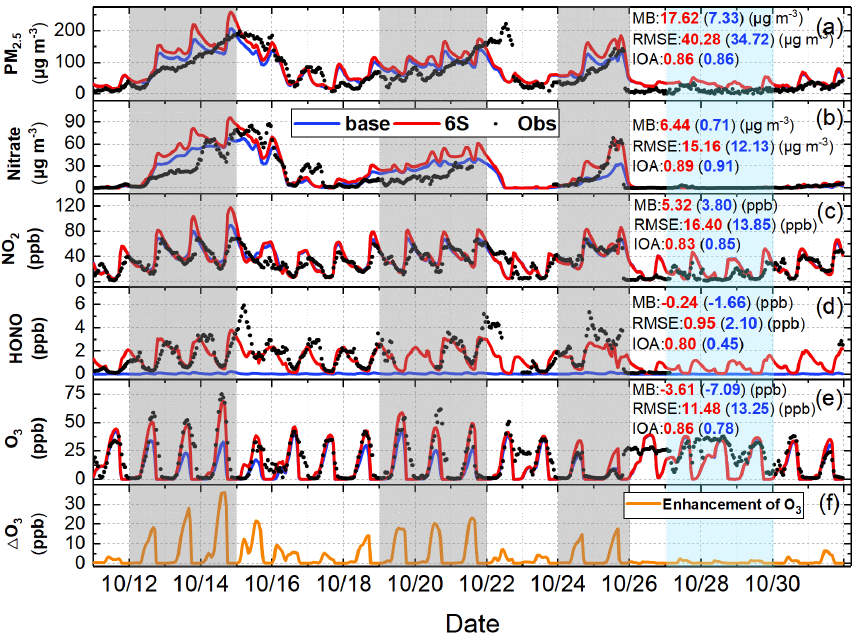
Figure 2. Comparison of simulated (Base and 6S cases) and observed hourly concentrations of PM 2 . 5 , nitrate, NO 2 , HONO, and O 3 (a–e) , and the hourly enhanced concentrations of O 3 ( (cid:49) O 3 ) (f) caused by the six potential HONO sources (6S minus Base) at the BUCT site during 11–31 October 2018.